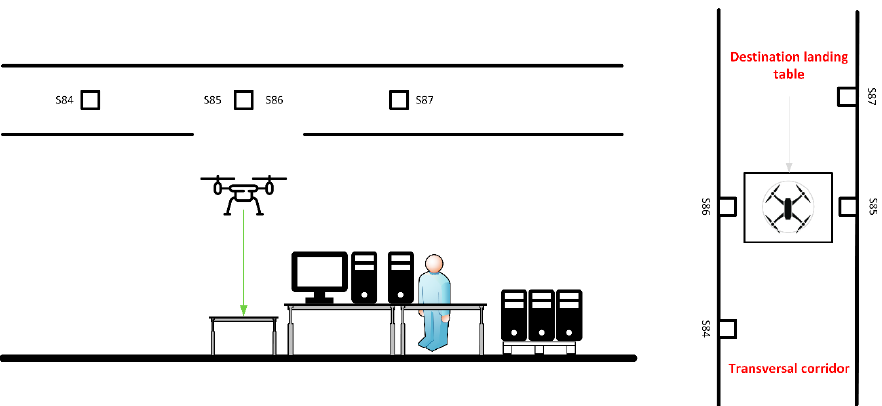
Figure 8. Vertical descent over operator’s landing table.